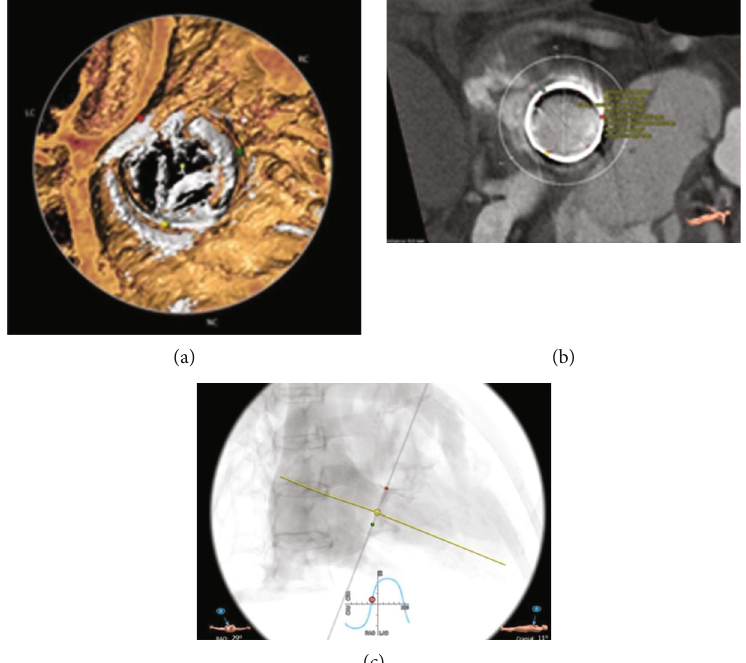
Figure 2: Cardiac computed tomography images: distribution of severe bioprosthetic lea fl et calci fi cation (a). Inner diameter of the bioprosthetic valve (26.3mm) (b). The best projection angles